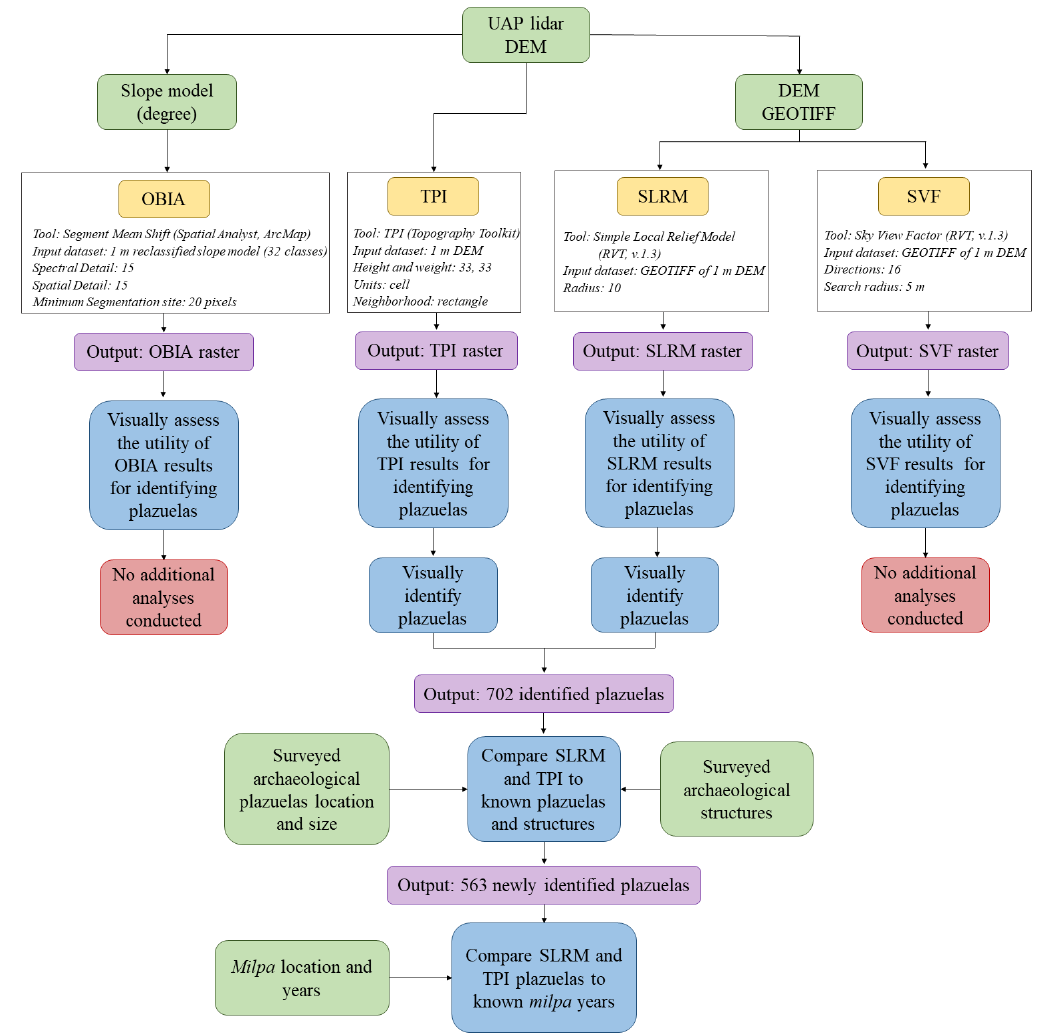
Figure 3. Flowchart of methods (blue boxes), inputs (green boxes), and outputs (purple boxes) used in the analysis of relief visualization techniques (yellow boxes) for archaeological prospection.